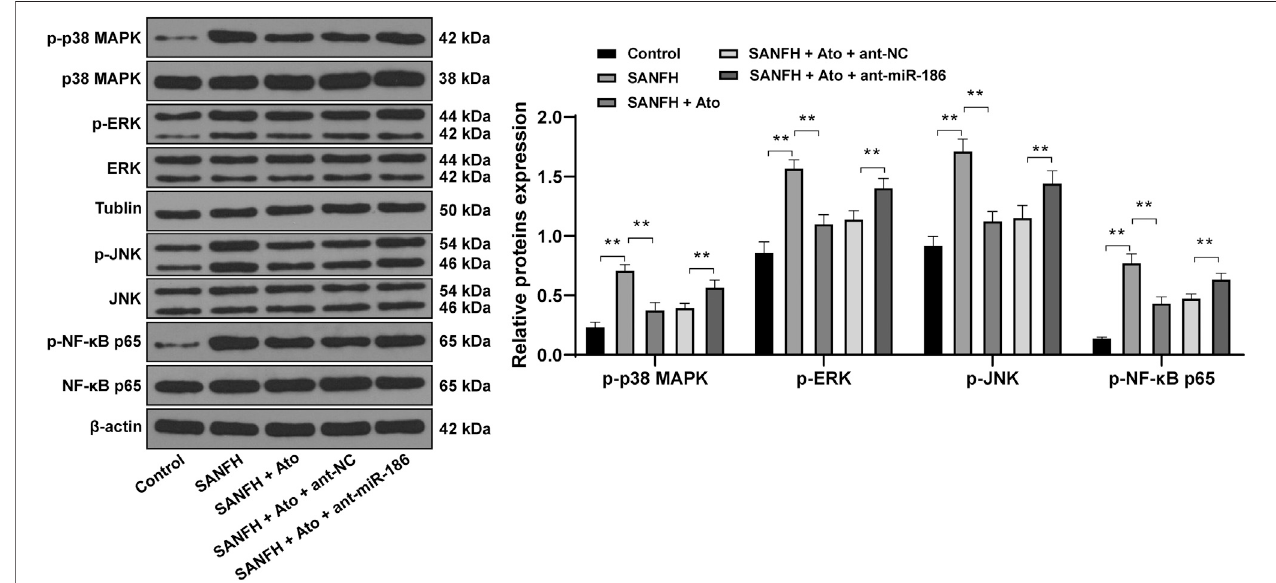
FIGURE4| AtoinhibitstheactivationoftheMAPKs/NF- κ Bpathway inSANFH.TheexpressionofMAPK/NF- κ Bpathway-relatedproteinsbyWesternblot. n (cid:1) 6in each group. ** p < 0.01.